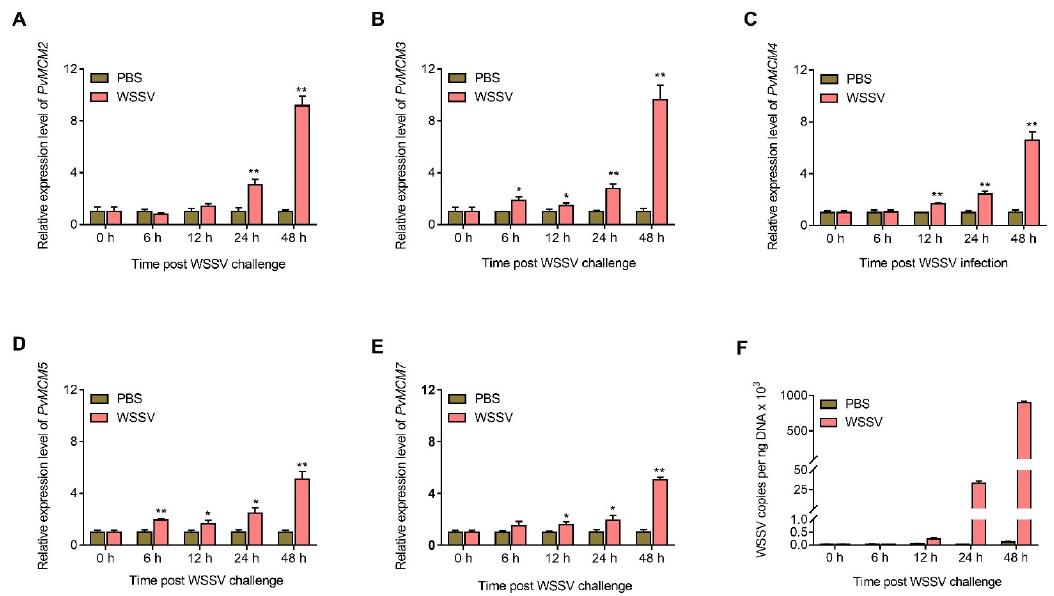
Figure 6. P. vannamei MCM complex genes are upregulated upon WSSV infection. ( A – E ) qPCR analysis of Pv MCM2, Pv MCM3, Pv MCM4, Pv MCM5, and Pv MCM7 expression after WSSV challenge. ( F ) qPCR analysis of virus copies number (viral loads). Shrimp were separately injected with WSSV or PBS (negative control). At 0, 6, 12, 24, and 48 h post viral infection, hemocytes per group were harvested and then used to determine the expression of P. vannamei MCM complex genes and viral loads using qPCR. All the qPCR assays were carried out in triplicate for each sample. The data were shown as mean ± SD, and the statistical significance between each group was analyzed by Student ’ s t -test (* indicates p < 0.05, and ** indicates p < 0.01). 2.5. P. vannamei MCM Complex Enhances WSSV Replication at the Early Infection Stage To further figure out the role of the P. vannamei MCM complex in WSSV infection, RNAi assay was performed. In this study, we selected Pv MCM2 for RNAi analysis as it is